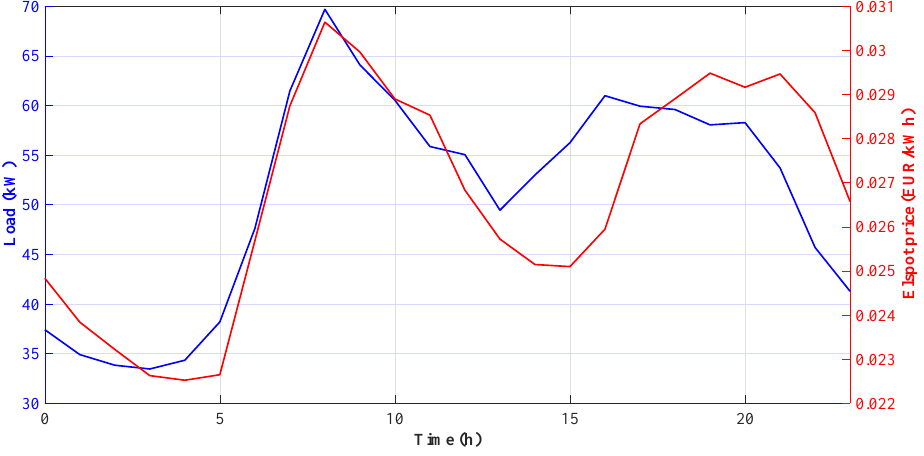
Figure 3. Weekly mean boat demand and Elspot